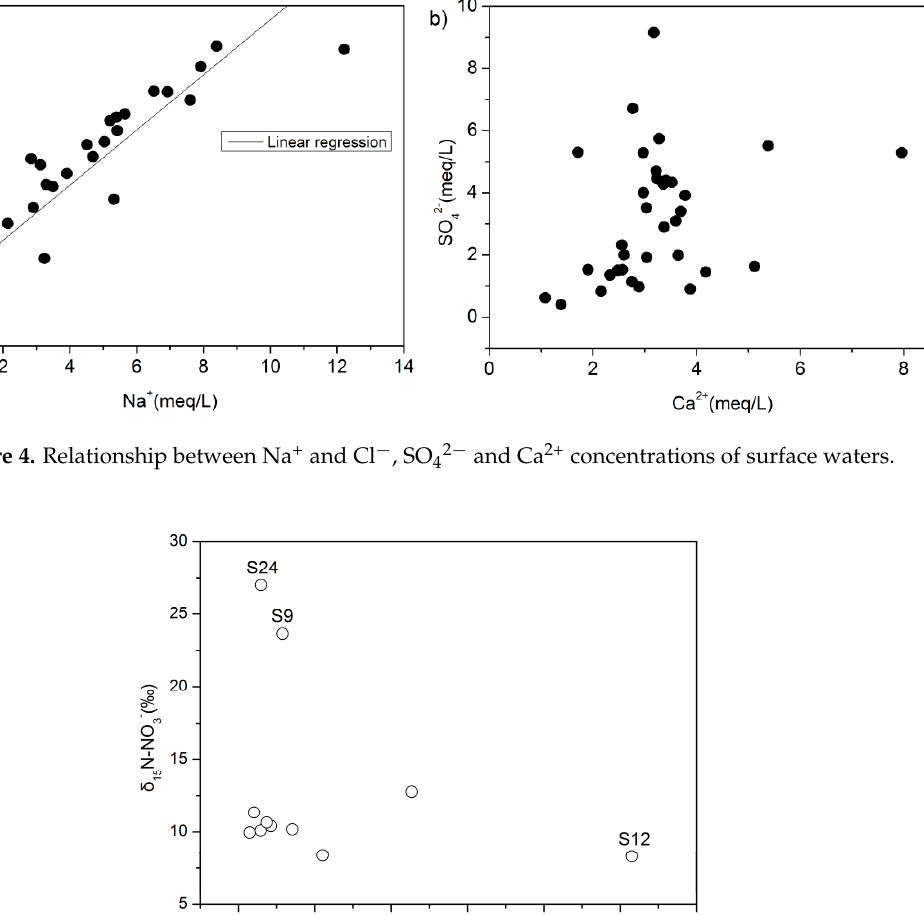
Figure 5. Relationship between NO 3 − ‐ N and δ 15 N ‐ NO 3 − in surface waters.